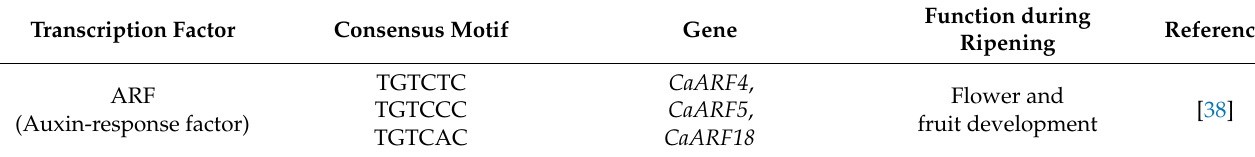
Table 1. Transcription factors involved in the fruit ripening of Capsicum